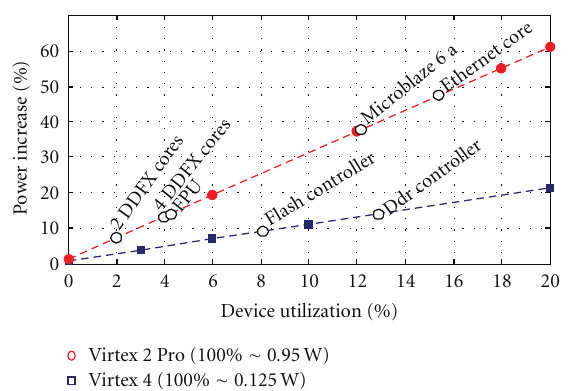
Figure 13: Virtex II Pro and Virtex 4 static power consumption and interpolated power consumption of commonly used peripherals in embedded systems. The red circles and blue squares represent data points obtained through direct measurements following the setup in Section